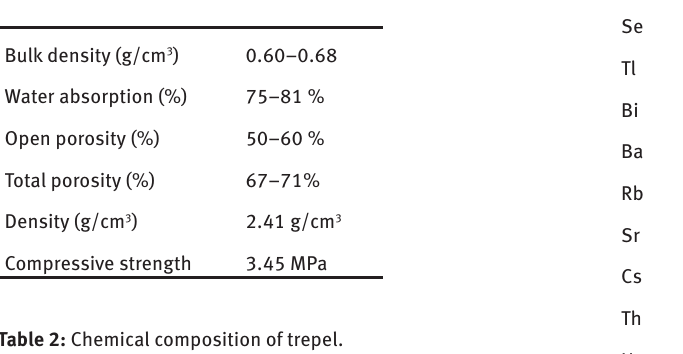
Table 1: Physical mechanical properties of raw trepel.